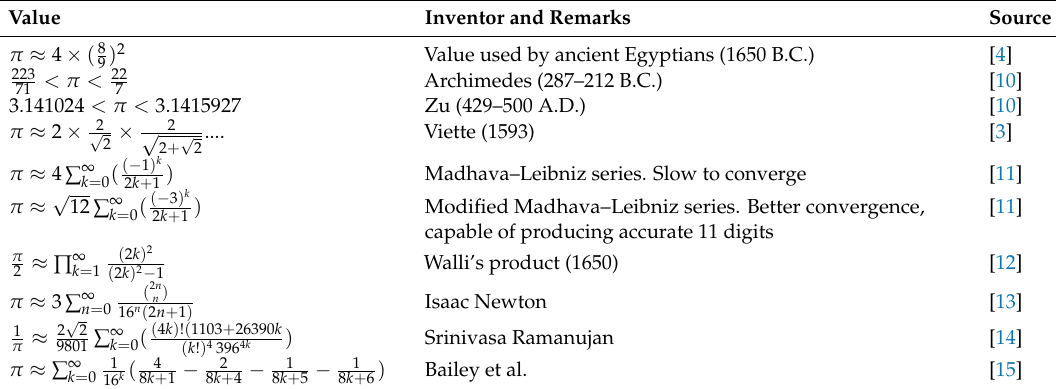
Table 1. Main equations pertaining to the value estimation of π